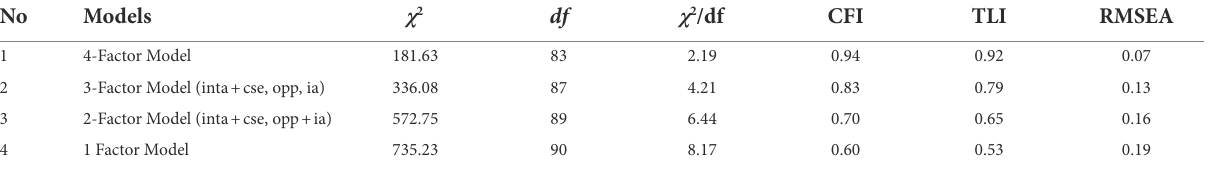
TABLE 4 Results of confirmatory factor analyses.